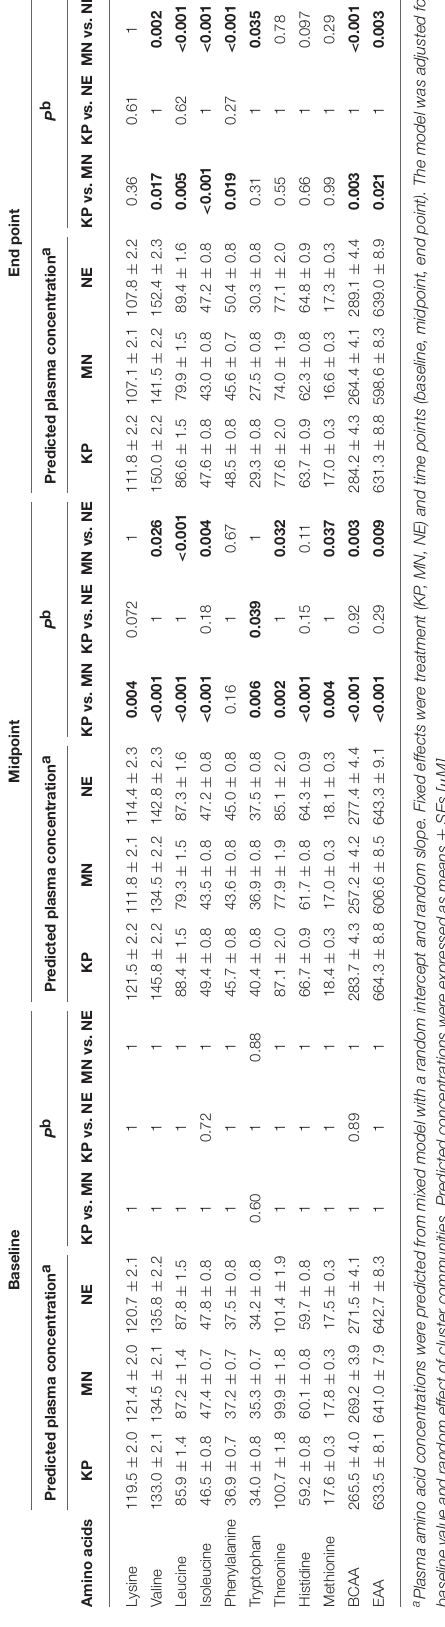
At end point, the KP group had estimated plasma BCAA concentrations ( ± SE) of 270.2 ± 6.4, 284.5 ± 4.2, and 298.8 ± 6.6 µ M at consumption levels of 100, 200, and 300 sachets, respectively. In contrast, the estimated plasma BCAA concentrations in the MN group at those consumption